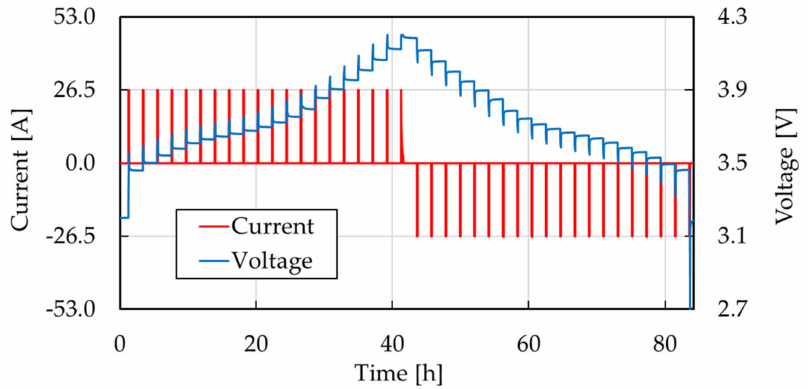
Figure 7. Step-response test data at 0.5 and 25 ◦